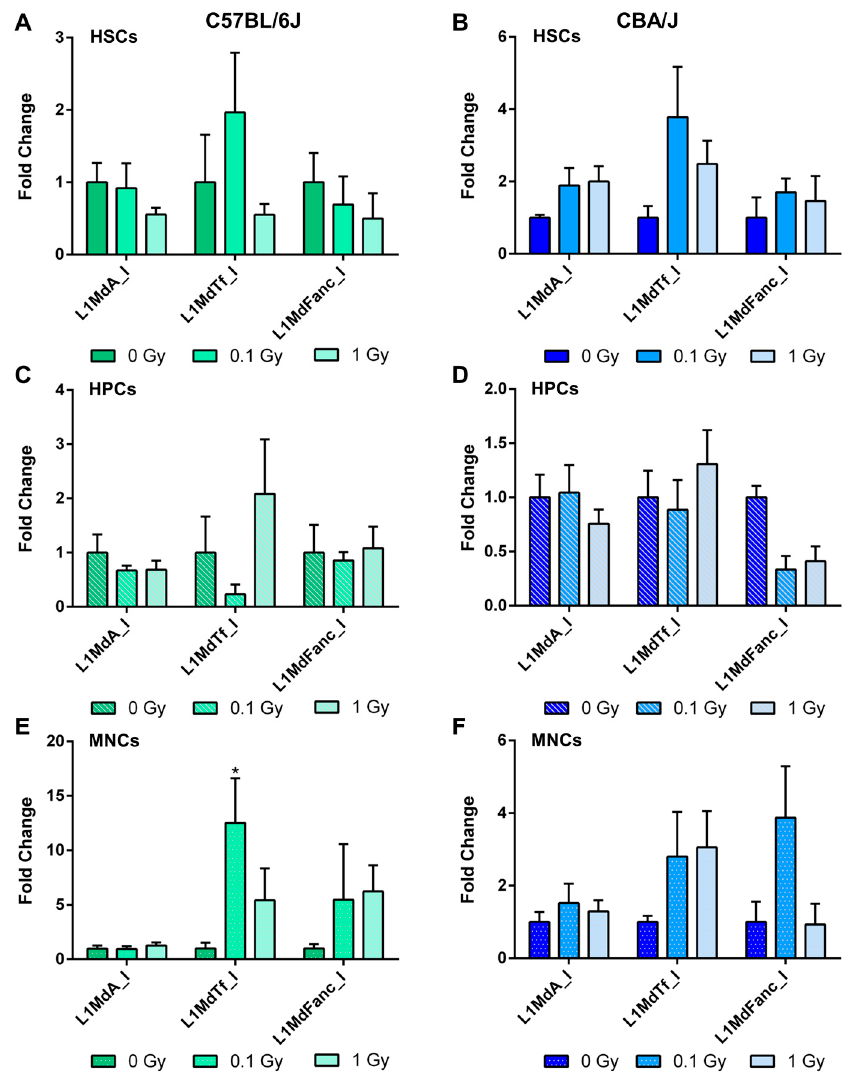
Figure 6. Comparative analysis of expression of three evolutionary distinct LINE-1 elements in the hematopoietic system of C57BL/6J and CBA/J mice in response to low-dose radiation. The differential expression of LINE-1 elements was determined by quantitative RT-PCR in ( A , B ) hematopoietic stem cells, ( C , D ) hematopoietic progenitor cells, and ( E , F ) mononuclear cells in C57BL/6J ( A , C , E ) and CBA/J ( B , D , F ). Data are presented as mean ± SEM ( n = 5). Asterisks (*) denote significant ( p < 0.05) difference from control. Sham-irradiated samples (0 Gy) were arbitrarily given a value of 1 for the purpose of comparison ( n = 5/group).